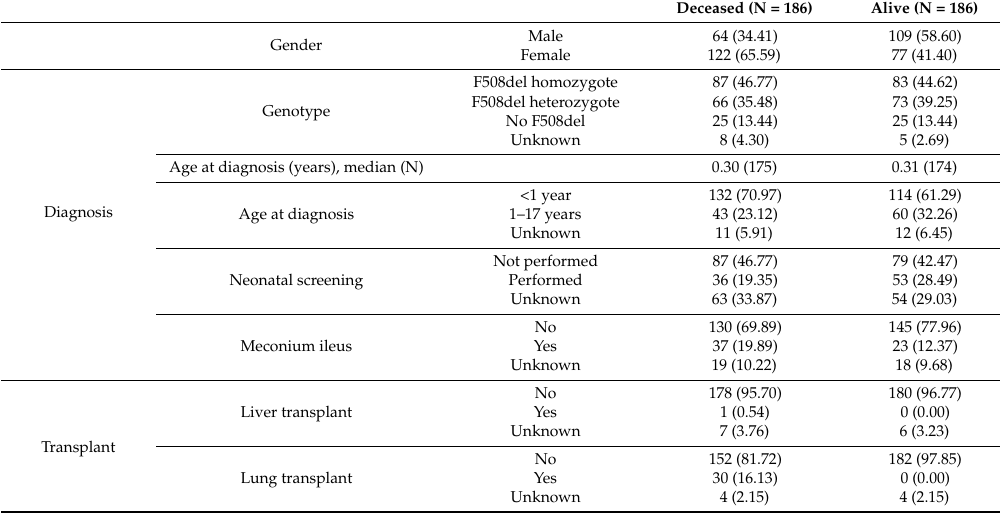
Table 1. Main demographic and clinical characteristics of the 372 considered patients. The number of patients and the percentage (in brackets) were reported unless otherwise